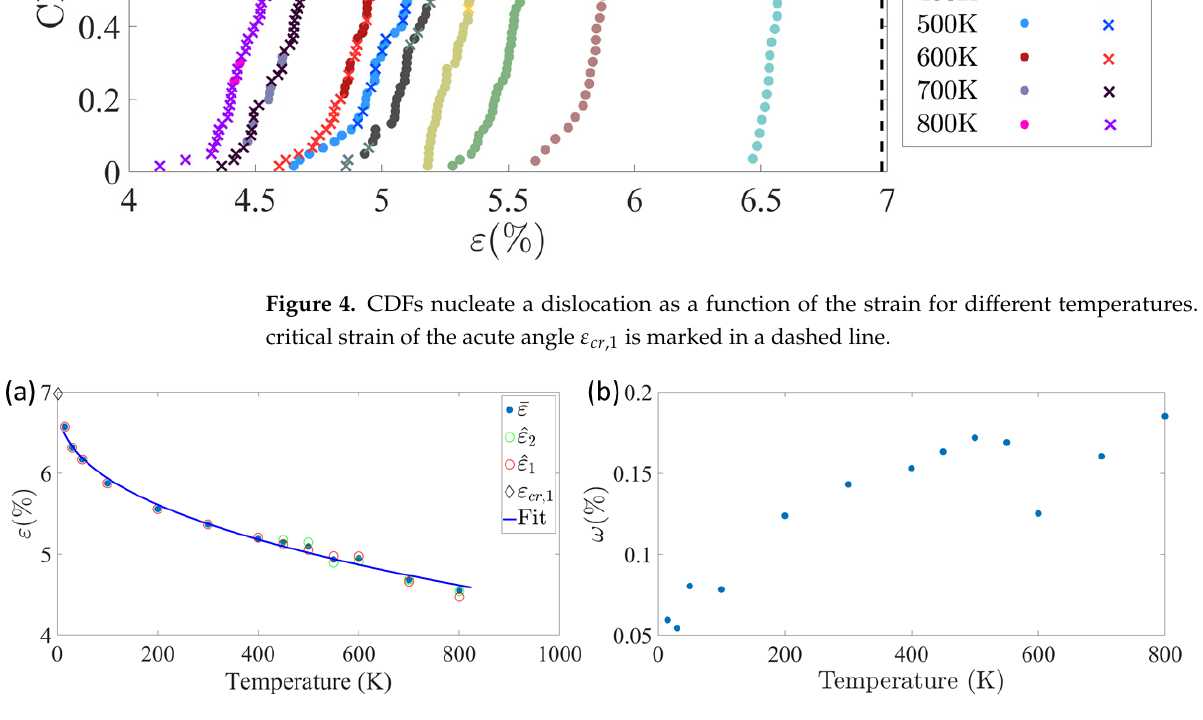
Figure 5. ( a ) Most probable nucleation strain 𝜀̅ and the average nucleation strain for each nucleation site in different temperatures. ( b ) Distribution width 𝜔 in different temperatures.